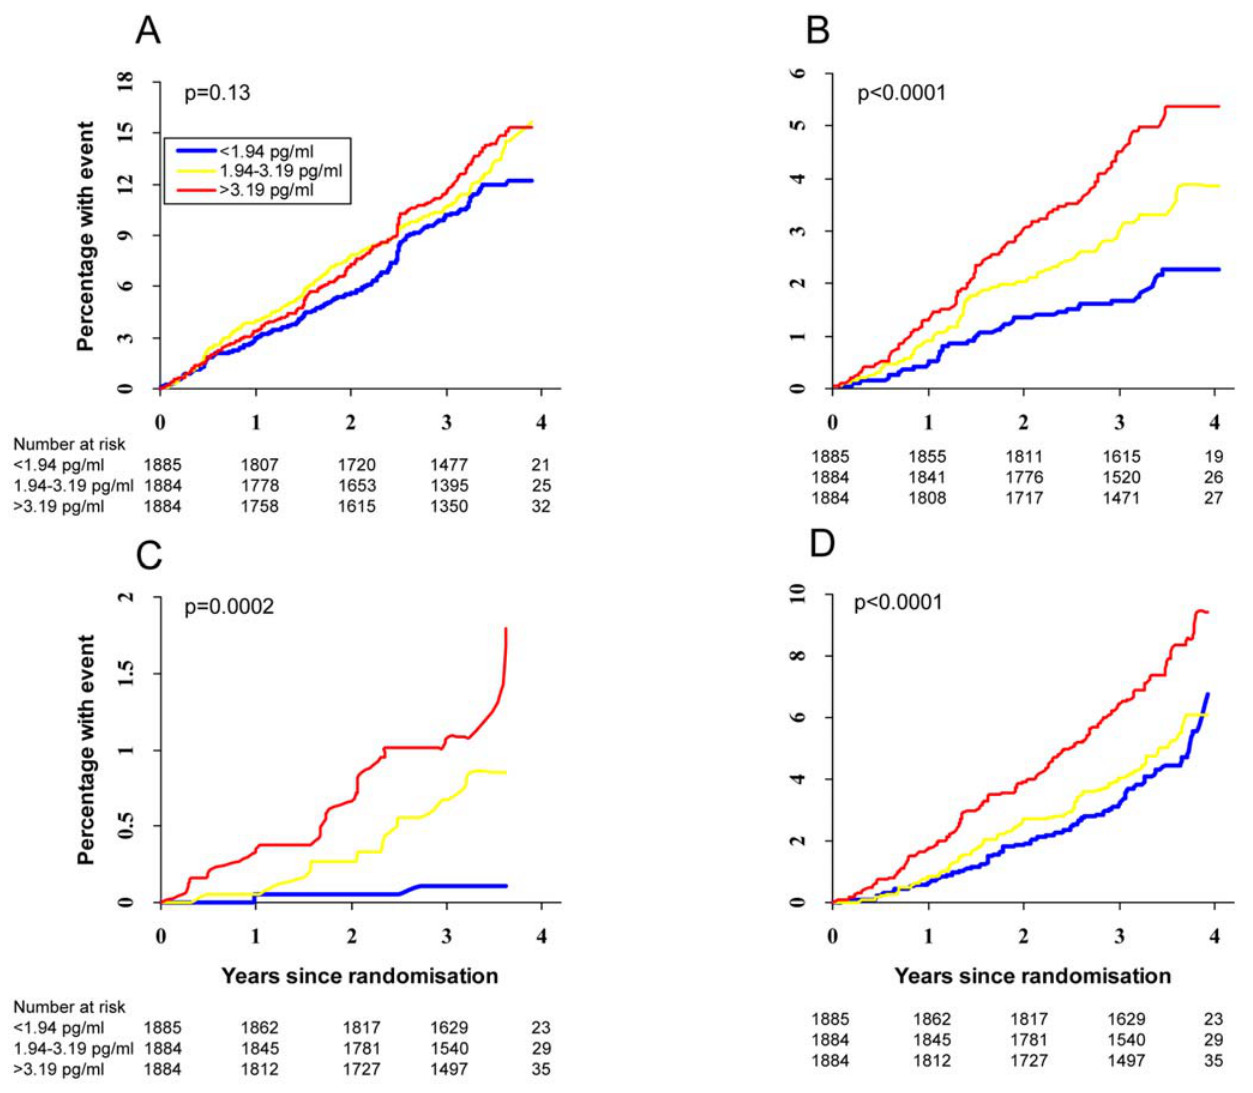
Figure 1. Kaplan-Meier time-to-event plots split by tertiles of IL-6 tertiles for (A) nonfatal CVD ( n =667 events), (B) fatal CVD ( n =189 deaths), (C) fatal other CV ( n =37 deaths), and (D) non-CVD mortality ( n =299 deaths).